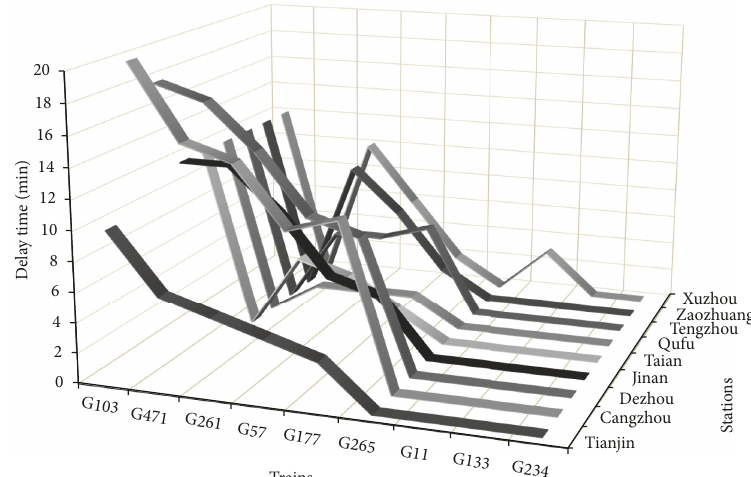
Figure 9: The delay time of each train at each station.